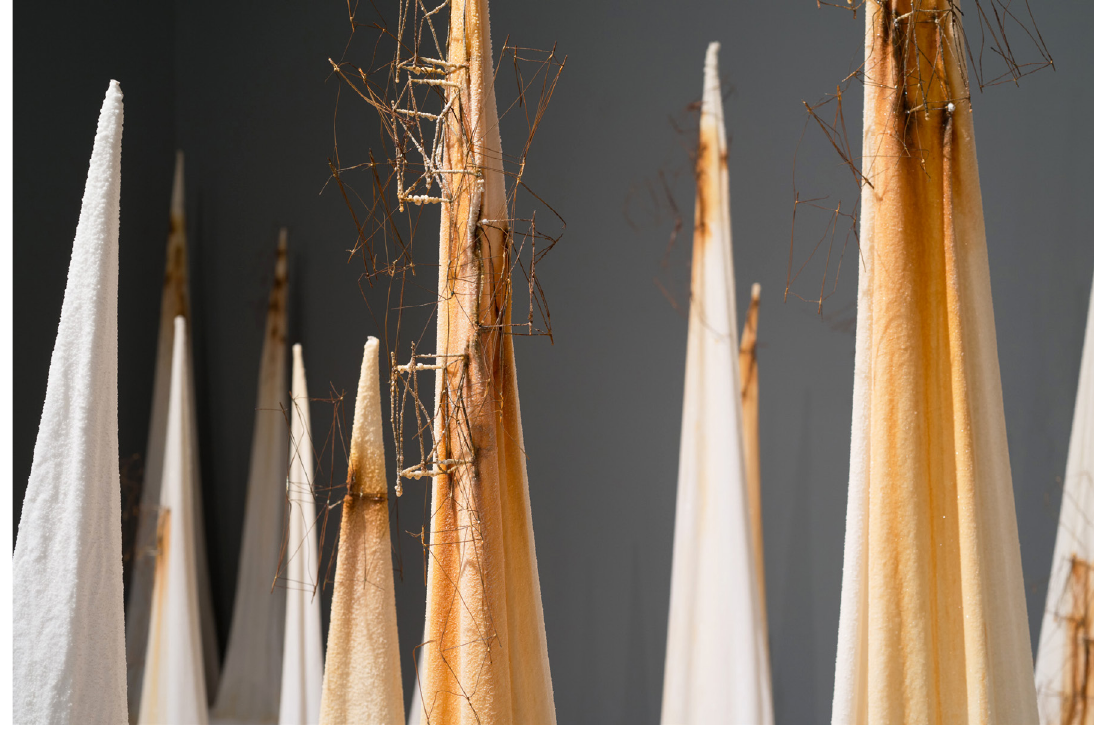
Figure 2: Tracey Clement, Post-Premonitionism 2 (detail), 2014-17, salt, rusty steel, cotton, dimensions variable, max height 180